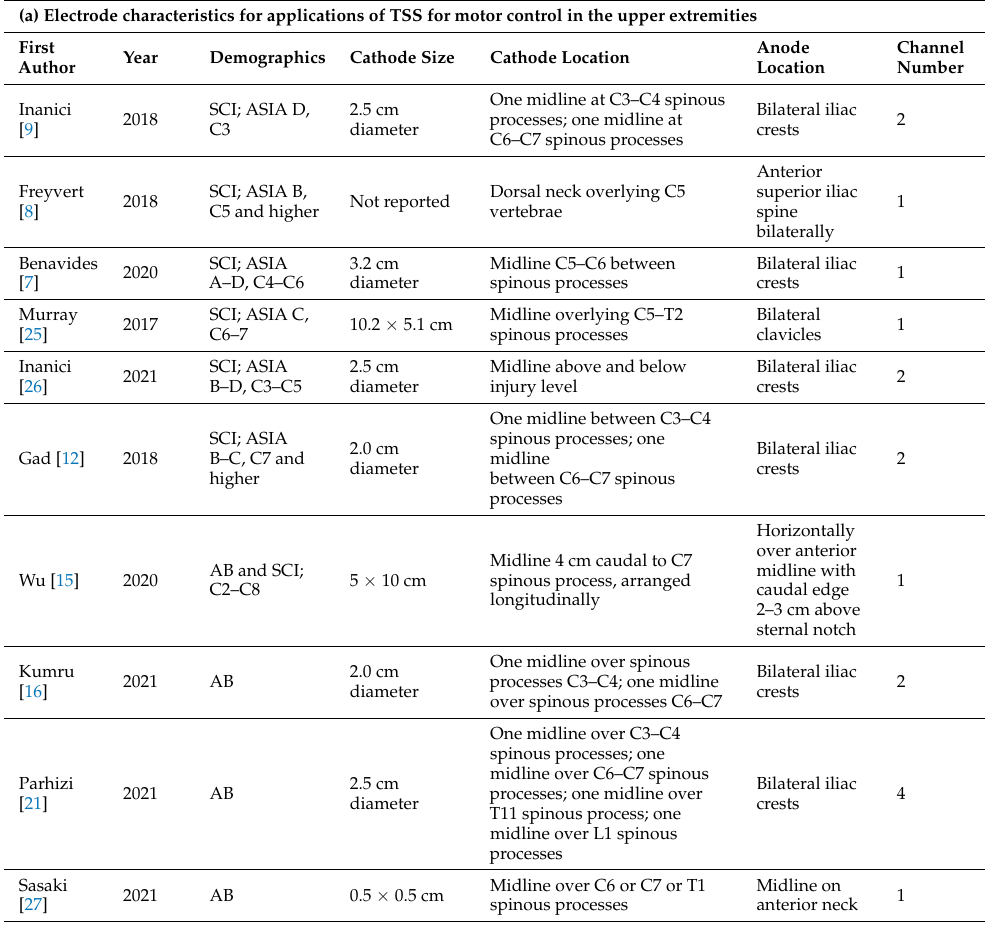
Table 1. Electrode characteristics for applications of TSS for motor control in the upper extremities. (a) Electrode characteristics for applications of TSS for motor control in the upper